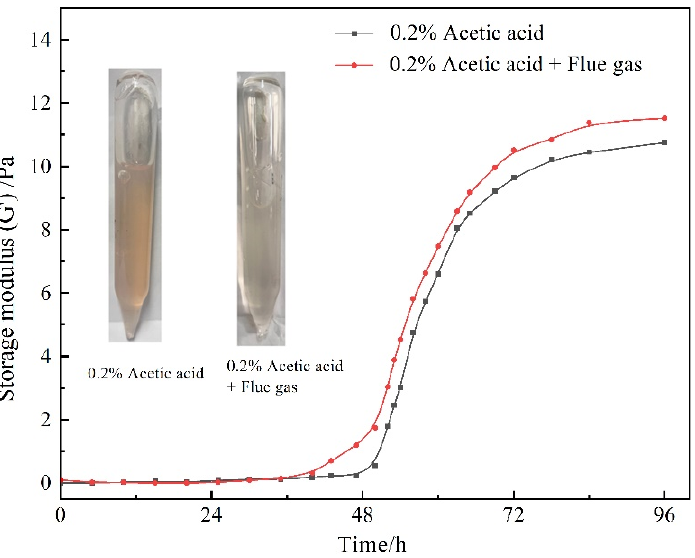
Figure 10. Gelation performance of gelant with 0.2 wt% acetic acid and flue gas.